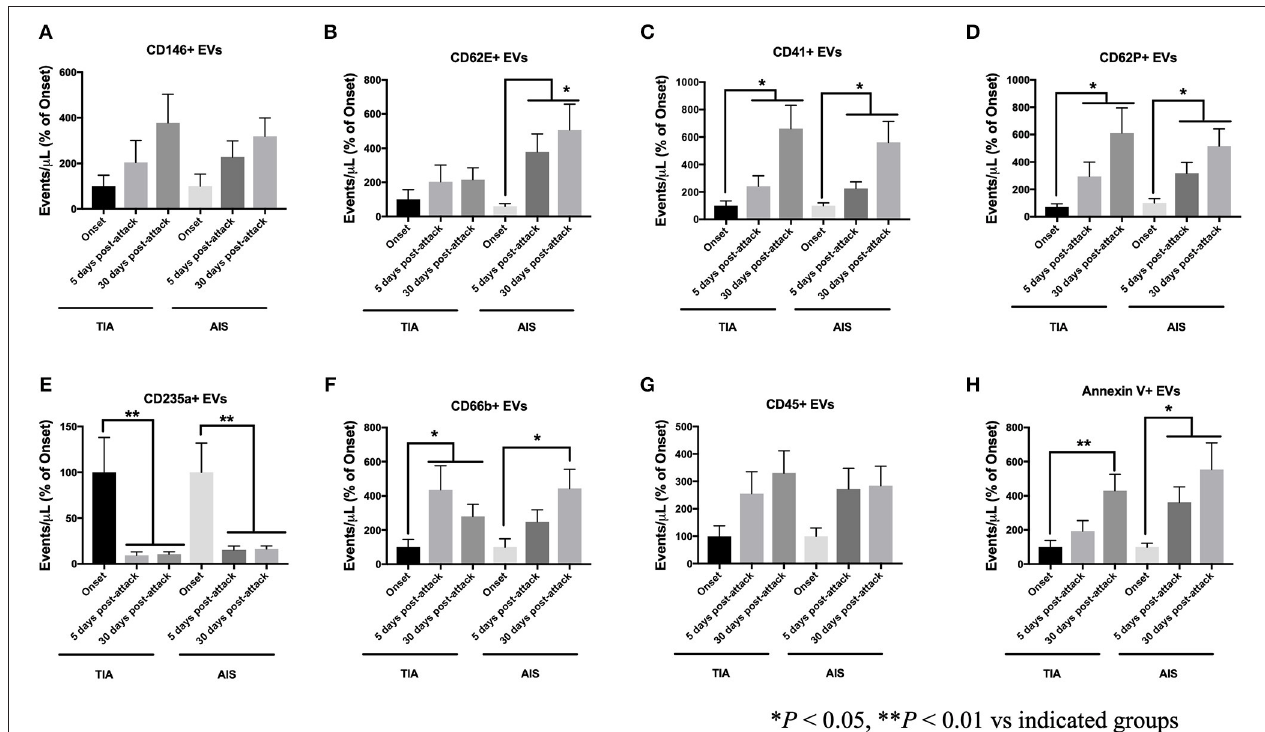
FIGURE 4 | Circulating EV levels, expressed as events/ µ L (% of onset levels), at onset, 5-days and 30-days post attacks, in PFP from patients with TIA and AIS. Histograms represent circulating levels of EVs derived from: (A) endothelial cells (CD146 + ), (B) activated endothelial cells (CD62E + ), (C) platelets (CD41), (D) activated platelets (CD62P + ), (E) erythrocytes (CD235a + ), (F) granulocytes (CD66b + ), (G) leukocytes (CD45 + ), (H) and pro-coagulant (Annexin V + ) origins. Data are expressed as mean ± SEM. Controls, n = 24; TIA, n = 21; AIS, n = 66. * P < 0.05, ** P < 0.01 vs. indicated